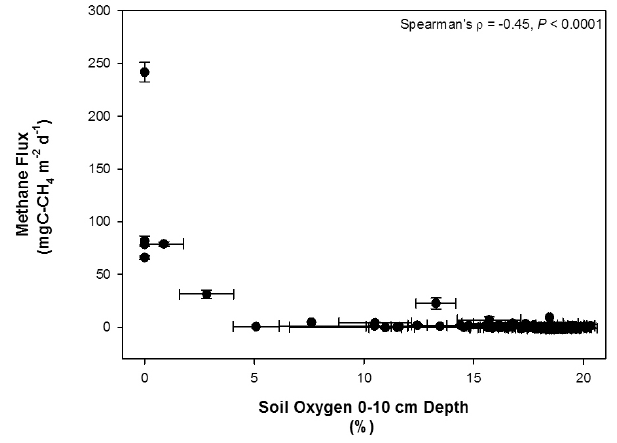
Fig. 5. Potential rates of N 2 O production, N 2 production and total (N 2 O + N 2 ) denitrification from 15 N-NO − laboratory tracer studies. 3 Kruskal–Wallis ANOVA ( P < 0.05) was used to test for differences among habitats. Lower case letters indicate statistically significant differences among means (Fisher’s LSD on rank transformed data, P <